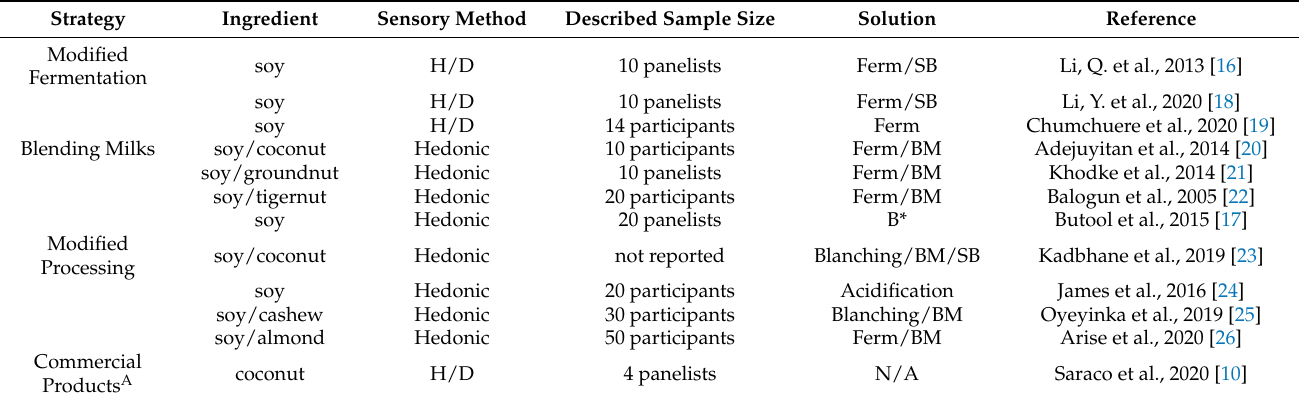
Table 1. Overview of PBCS articles employing sensory